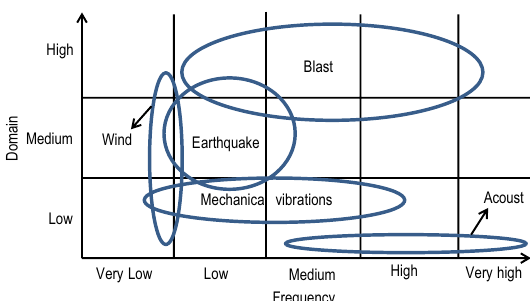
Fig. 1. The comparison between frequency and amplitude of different forces included of earthquake, explosion, wind, mechanical vibration, acoustic (DOD Ammunition ... 2008)